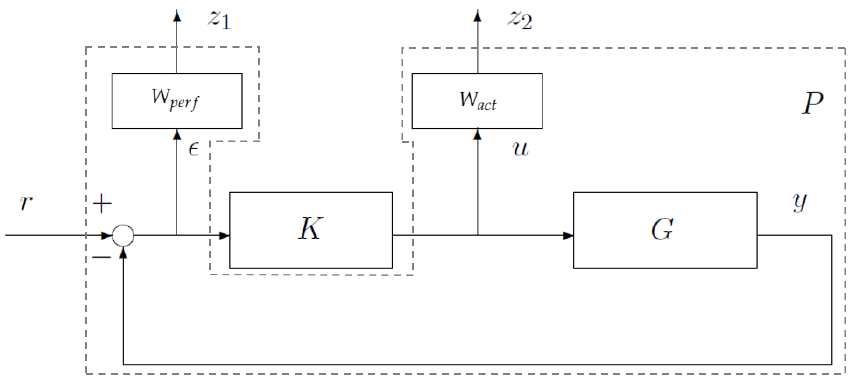
Figure 16. Example of a double criteria H . ∞